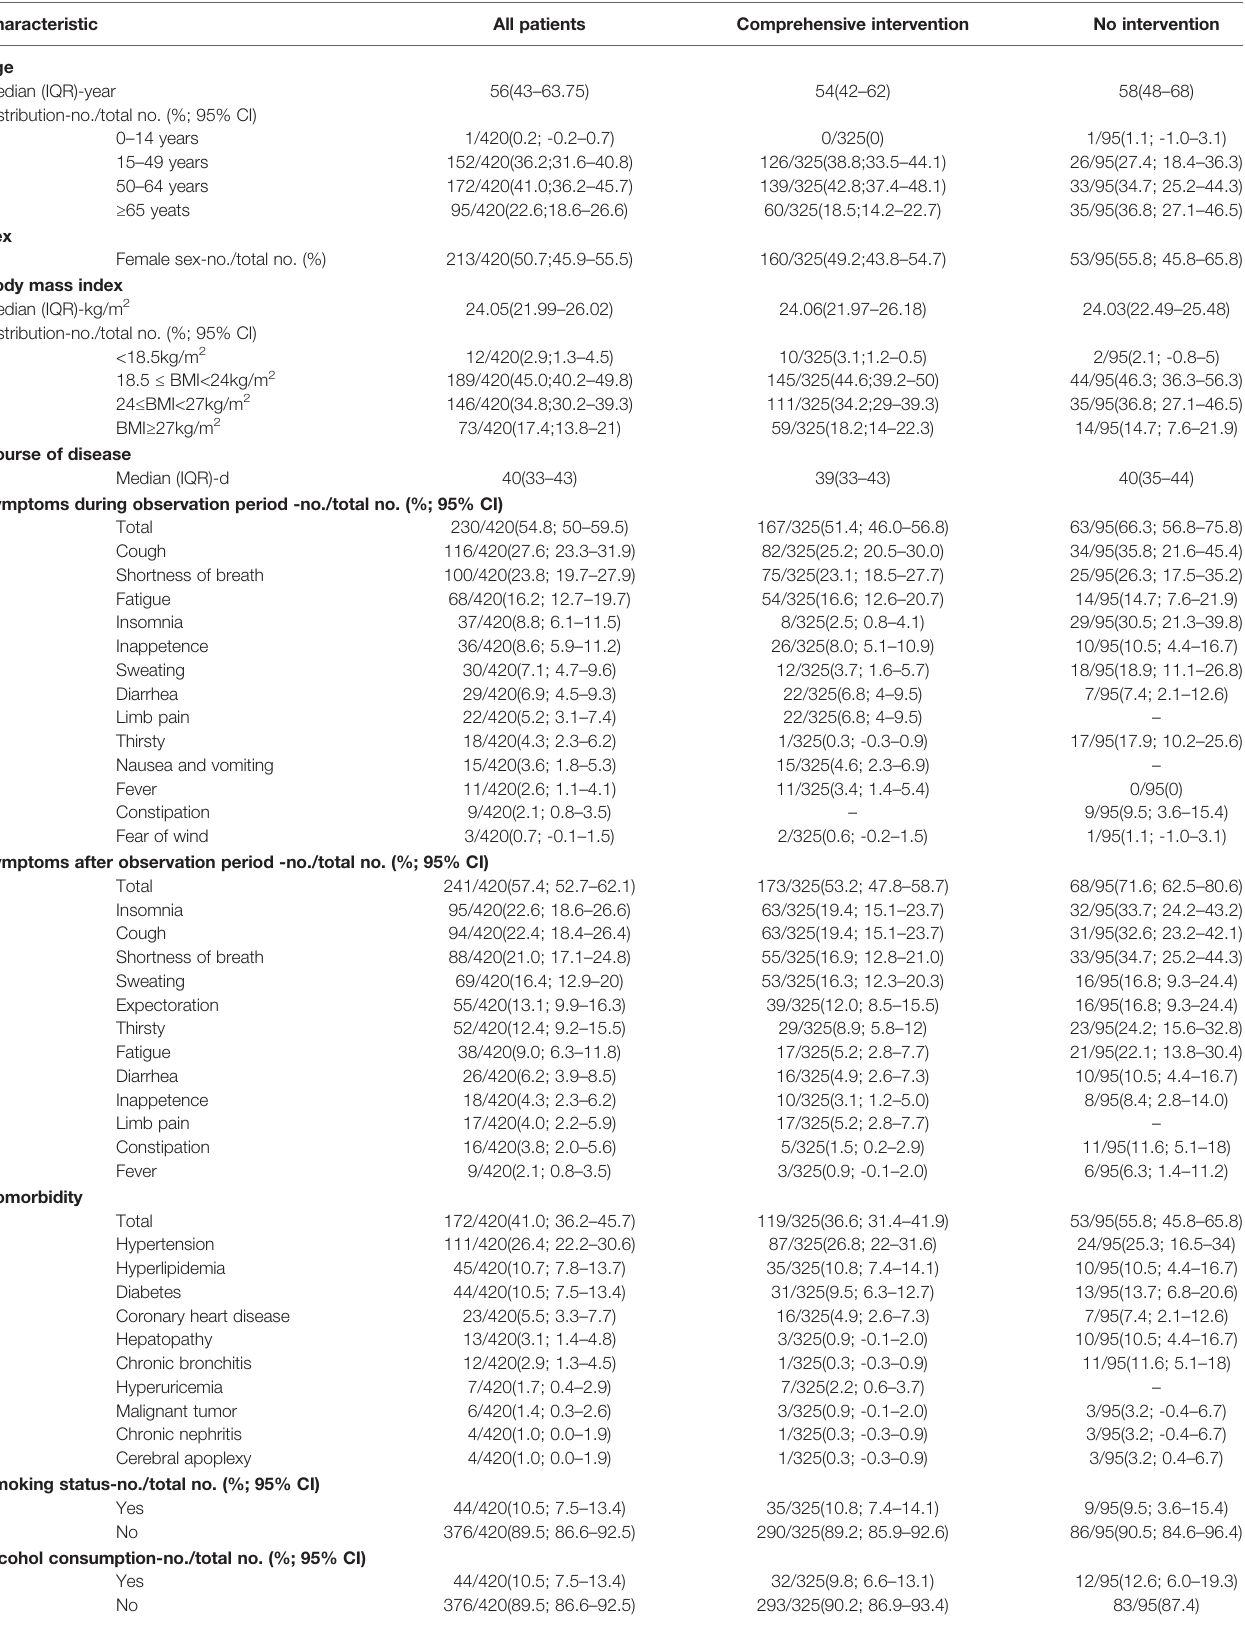
TABLE 1 | Characteristics of study observed person.